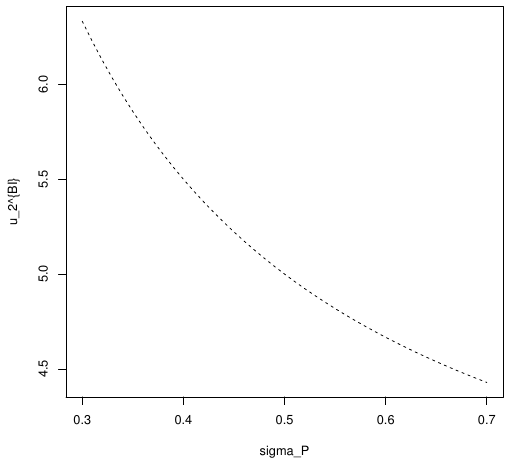
∗ ( 0 ) with negative λ P 2